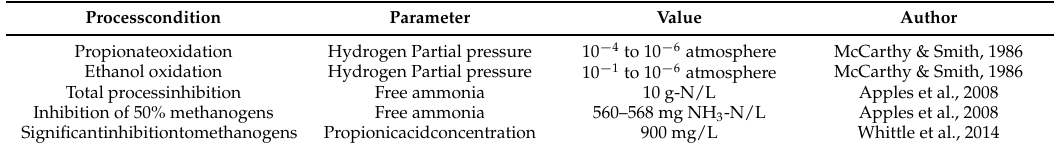
Table 2. Typical process stability parameters and control